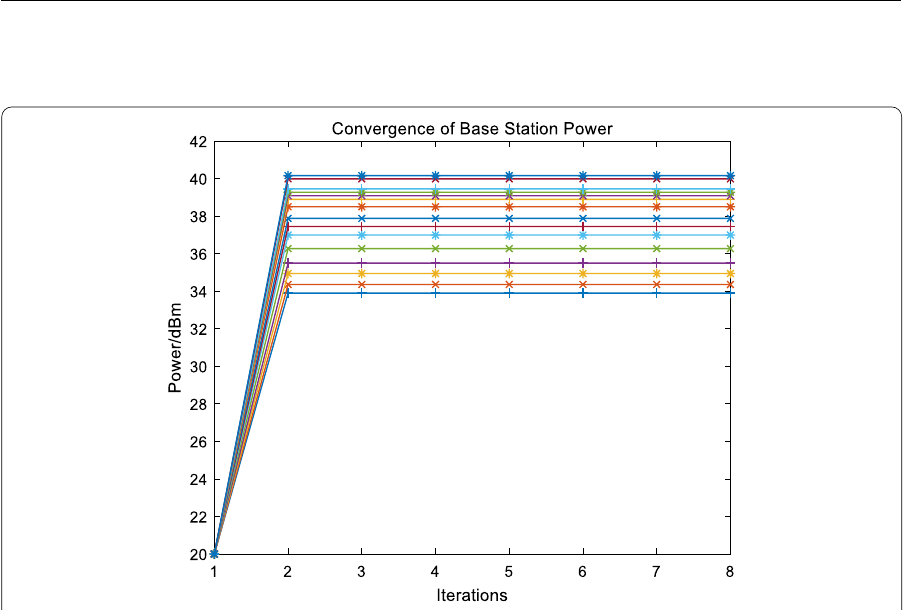
Fig. 2 Base station power varies with iteration. The figure shows the convergence of base station